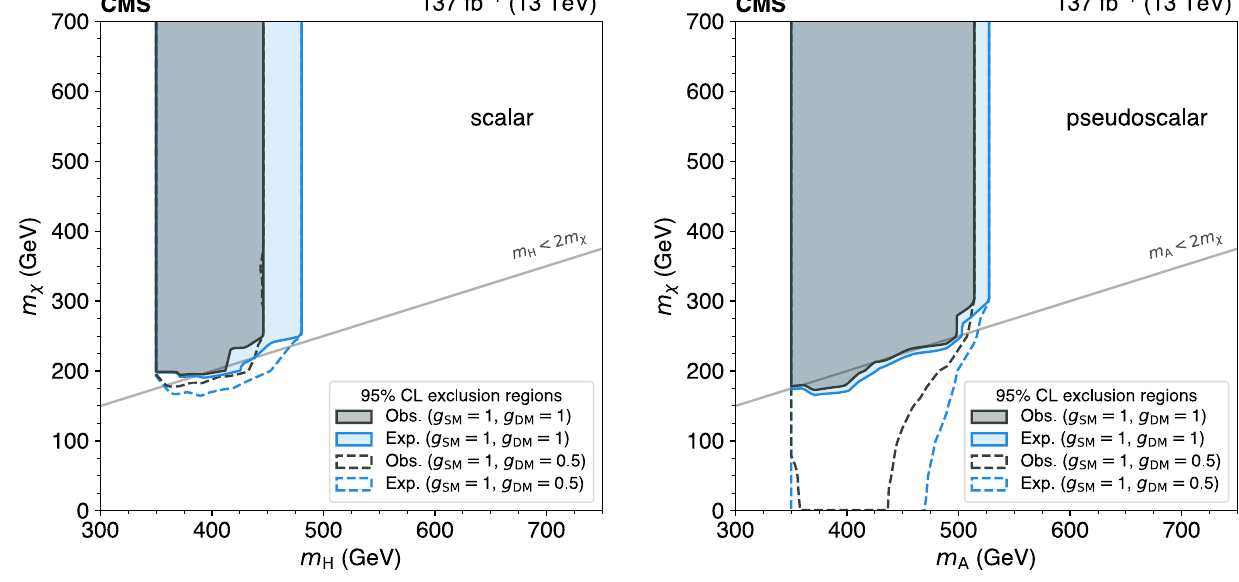
The excluded regions, shaded, are above the limit curves. The dashed lines show the limits assuming a weaker coupling between H / A and χ , g DM = 0 .